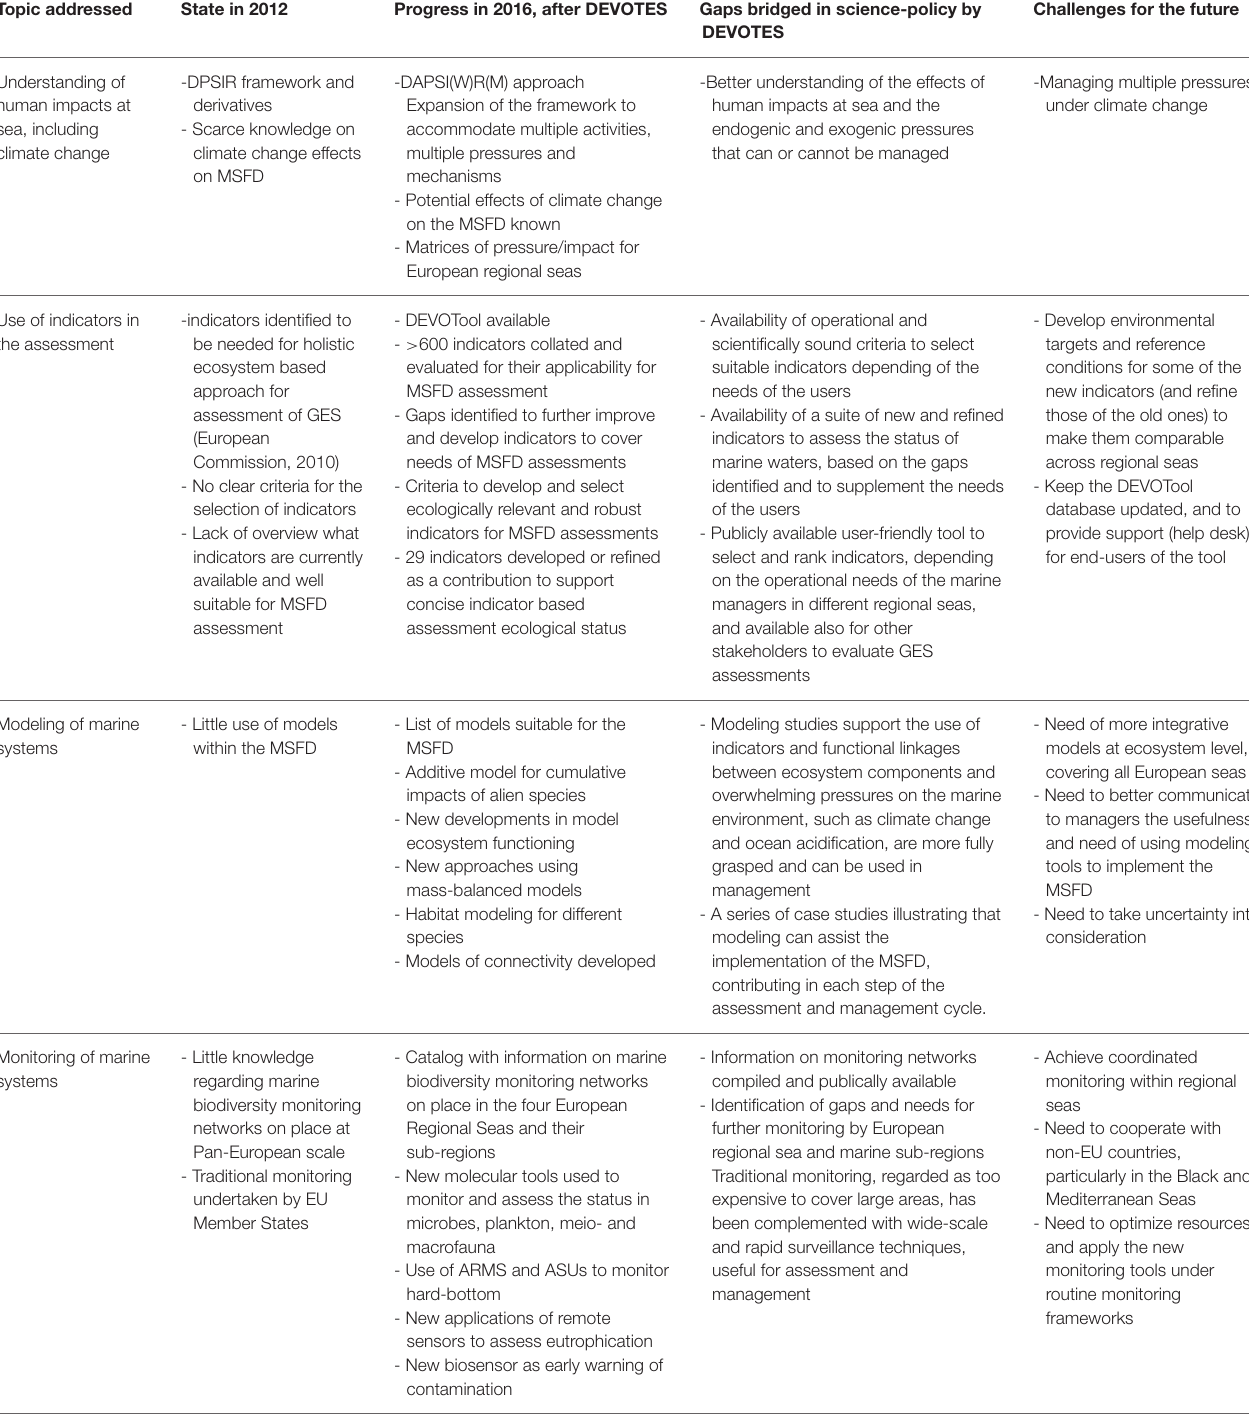
TABLE 2 | Progress beyond the state-of-the-art achieved by DEVOTES, within the different topics addressed by the project, and gaps bridged in science-policy. Topic